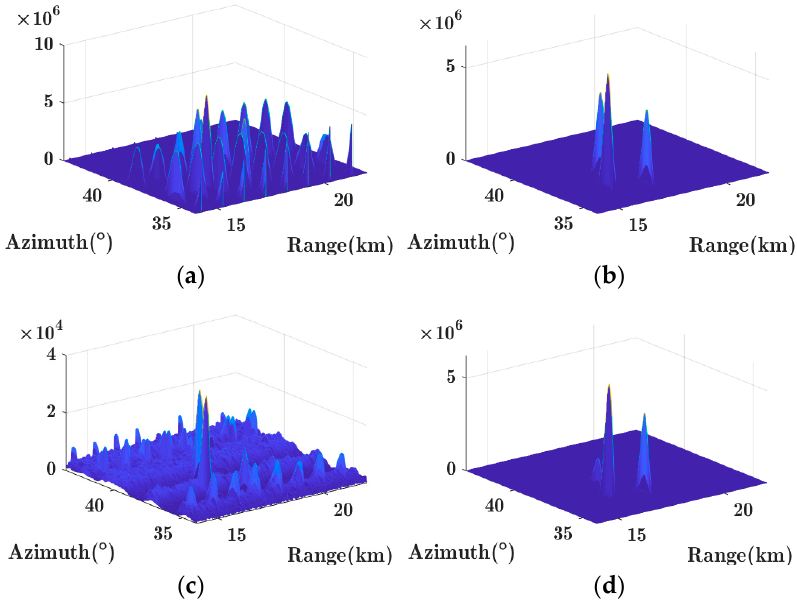
Figure 15. Results of mainlobe jamming suppression: ( a ) raw data; ( b ) proposed method; ( c ) blind source separation (BSS); ( d ) eigenprojection matrix processing (EMP).